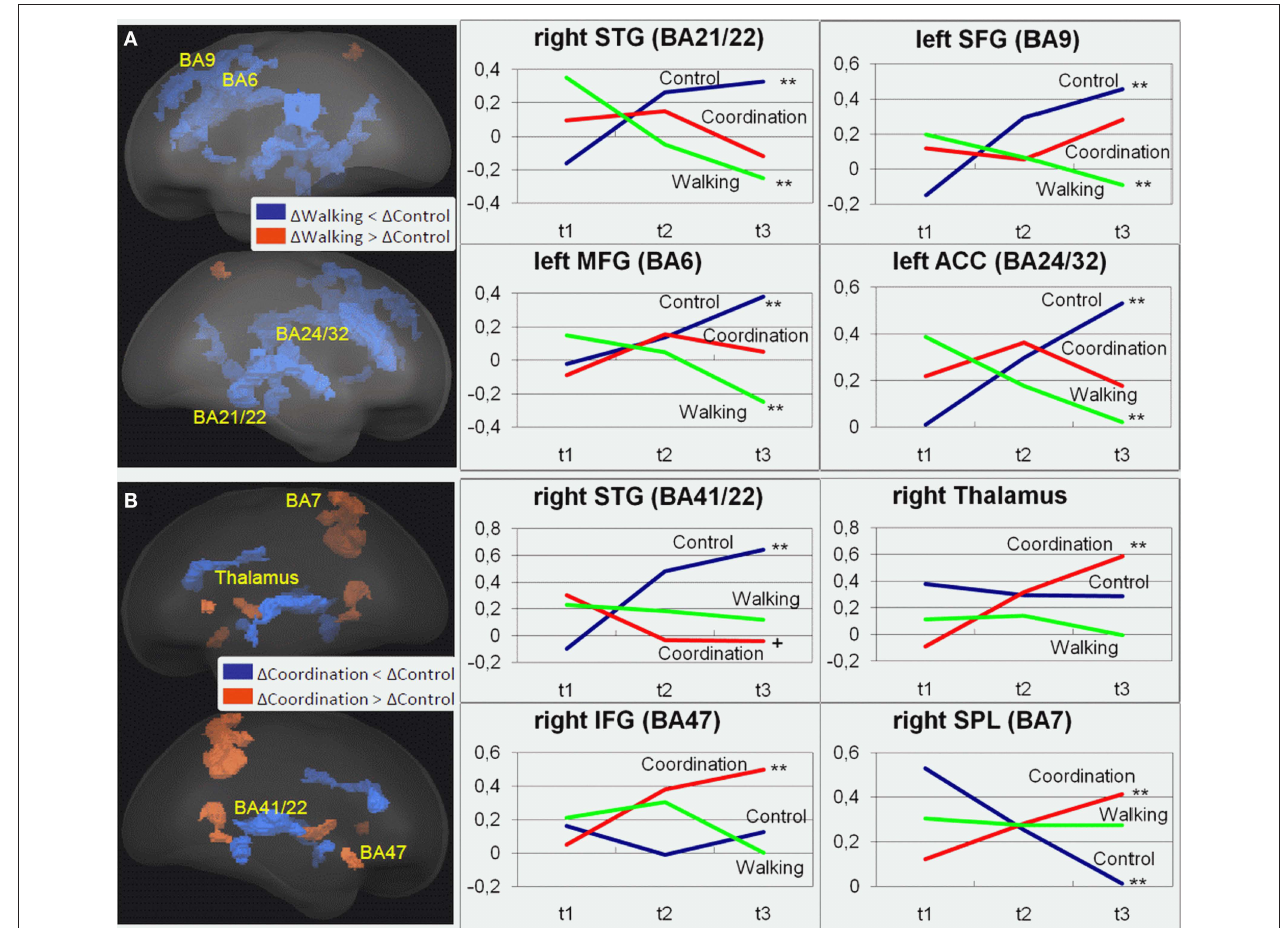
FIguRe 2 | Regions of interest (ROIs) that revealed significant contrasts for (A) cardiovascular training (walking) ( t 3– t 1) > control group (control) ( t 3– t 1) and (B) coordination training group (coordination) ( t 3– t 1) > control group (control) ( t 3– t 1) are projected into a standardized glass brain normalized